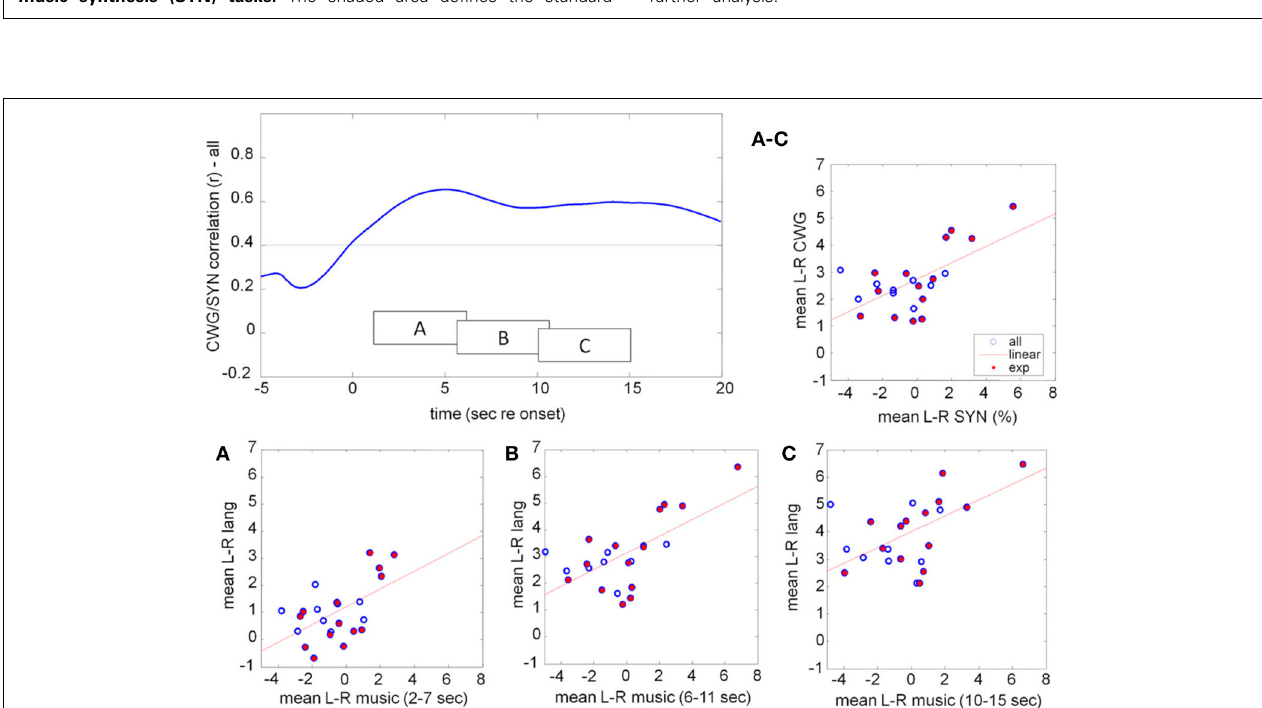
error over all subjects. The average data shown here hide a significant amount of inter-subject variability that forms the basis of further analysis.